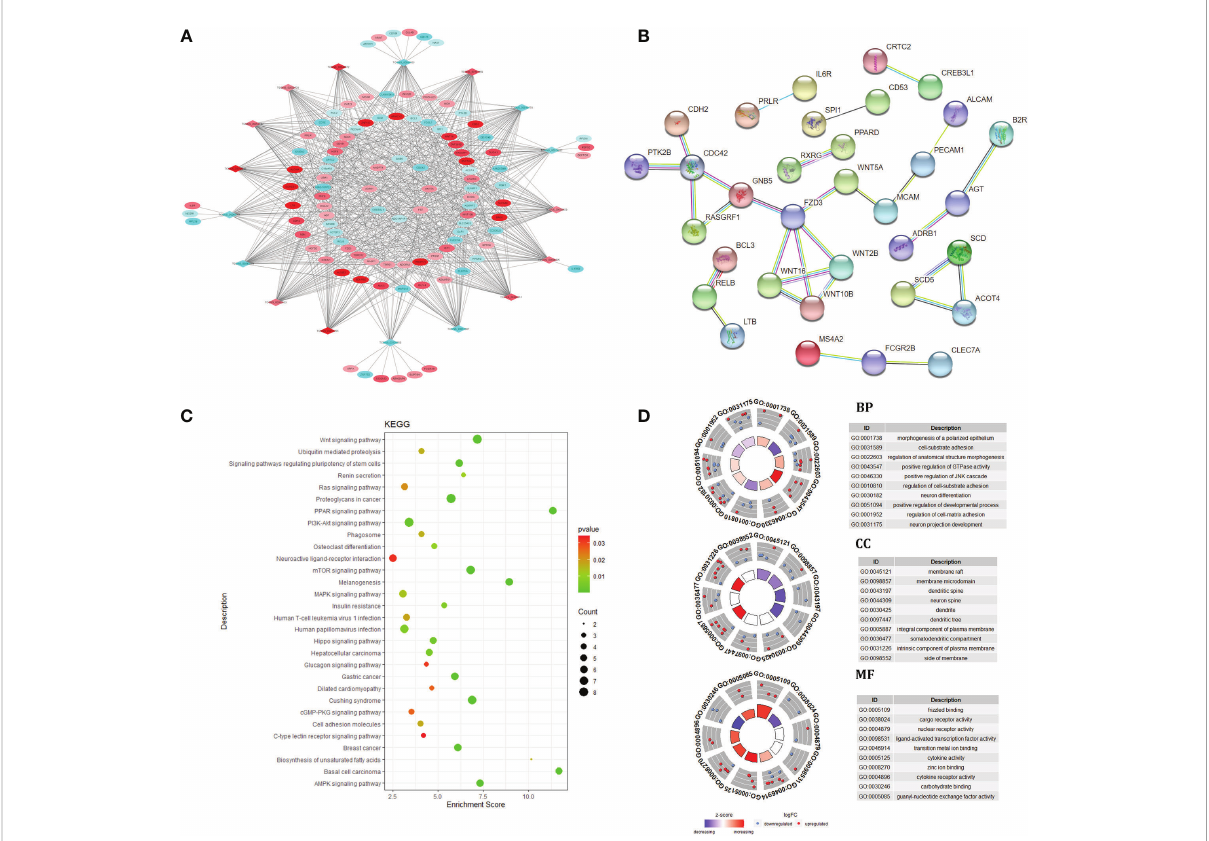
FIGURE 3 Co-expression network and target gene biology analysis. lncRNA and mRNA co-expression regulatory network (A) ; protein-protein interaction network (B) ; KEGG pathway enrichment analysis (C) ; GO enrichment results (D)